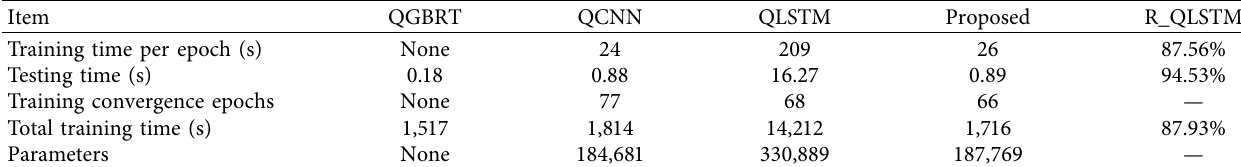
Table 5: Average efficiency comparison of 20